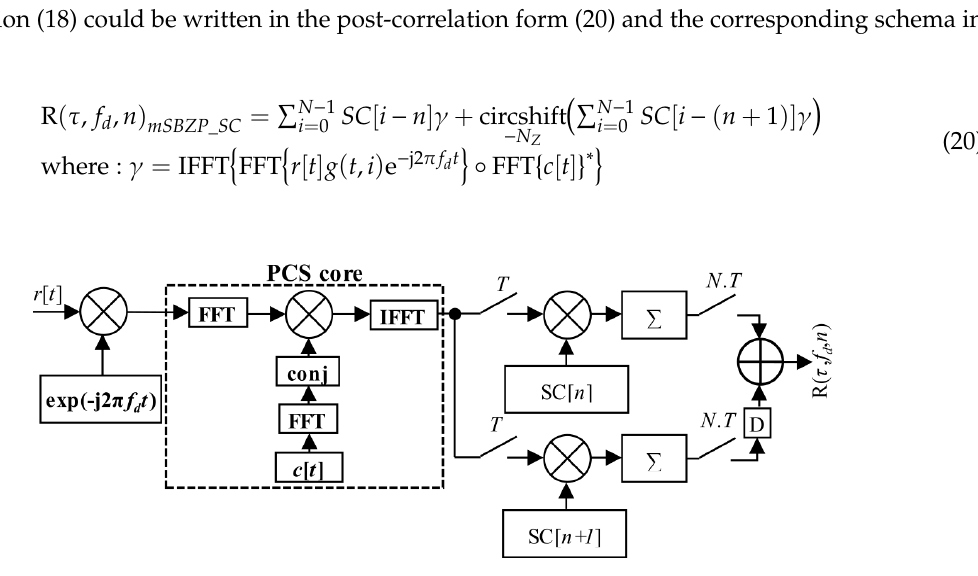
Figure 17. The mSBZP for SC algorithm, W ’ 1 and W ’ 2 -functions .